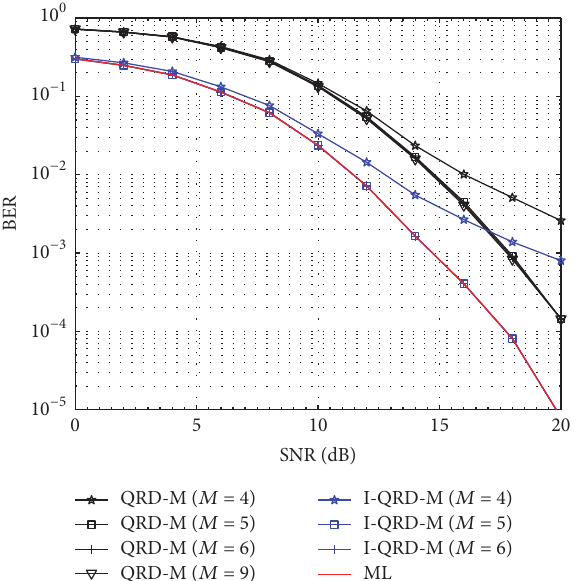
Figure 2: BER comparison for GSM scheme with 𝑁 𝑡 = 4 , 𝑁 𝑟 = 4 , and 𝑁 𝐴 = 2 for 16-QAM.